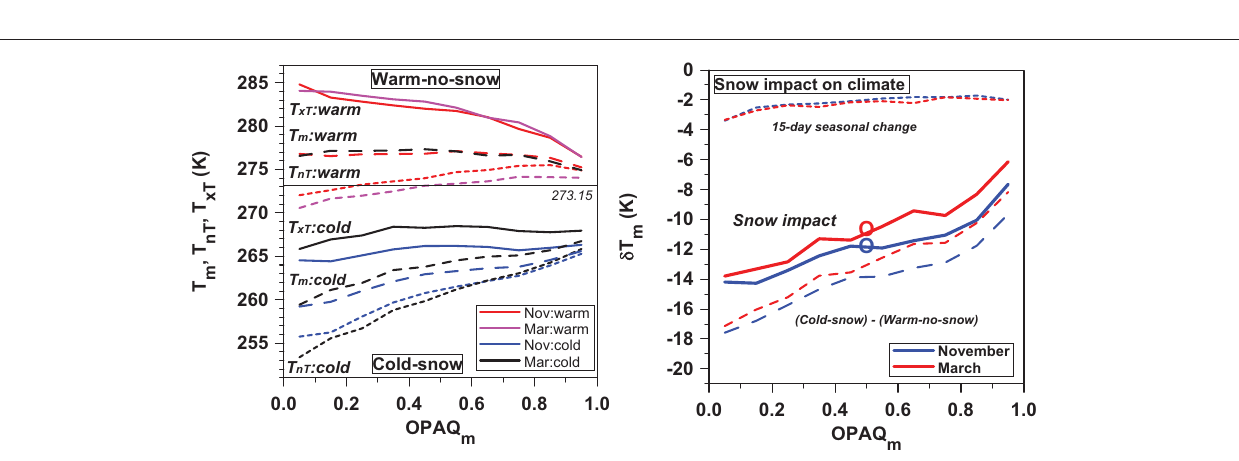
FIGURE 15 | T xT , T m and T nT (left), and (right) T m differences between cold-snow and warm-no-snow classes for November and March as a function of opaque cloud cover. Month color scheme legend (left) is for T xT .